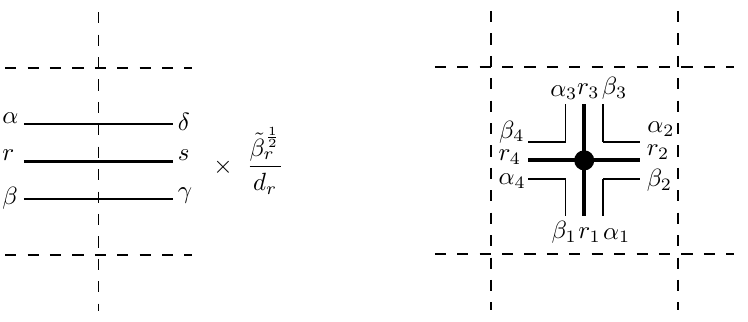
Figure 1 . The tensor associated with each link (Left) and that associated with each plaquette (Right) are depicted corresponding to (2.23) and (2.25),